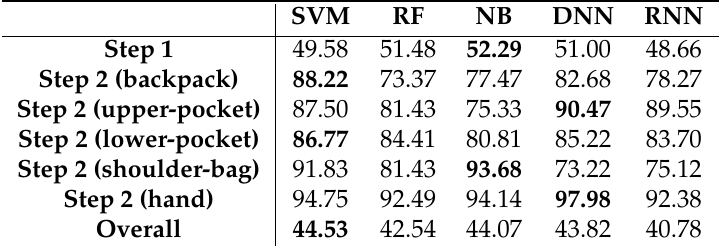
Table 5. Accuracies of possession-action recognition under one-user-out cross